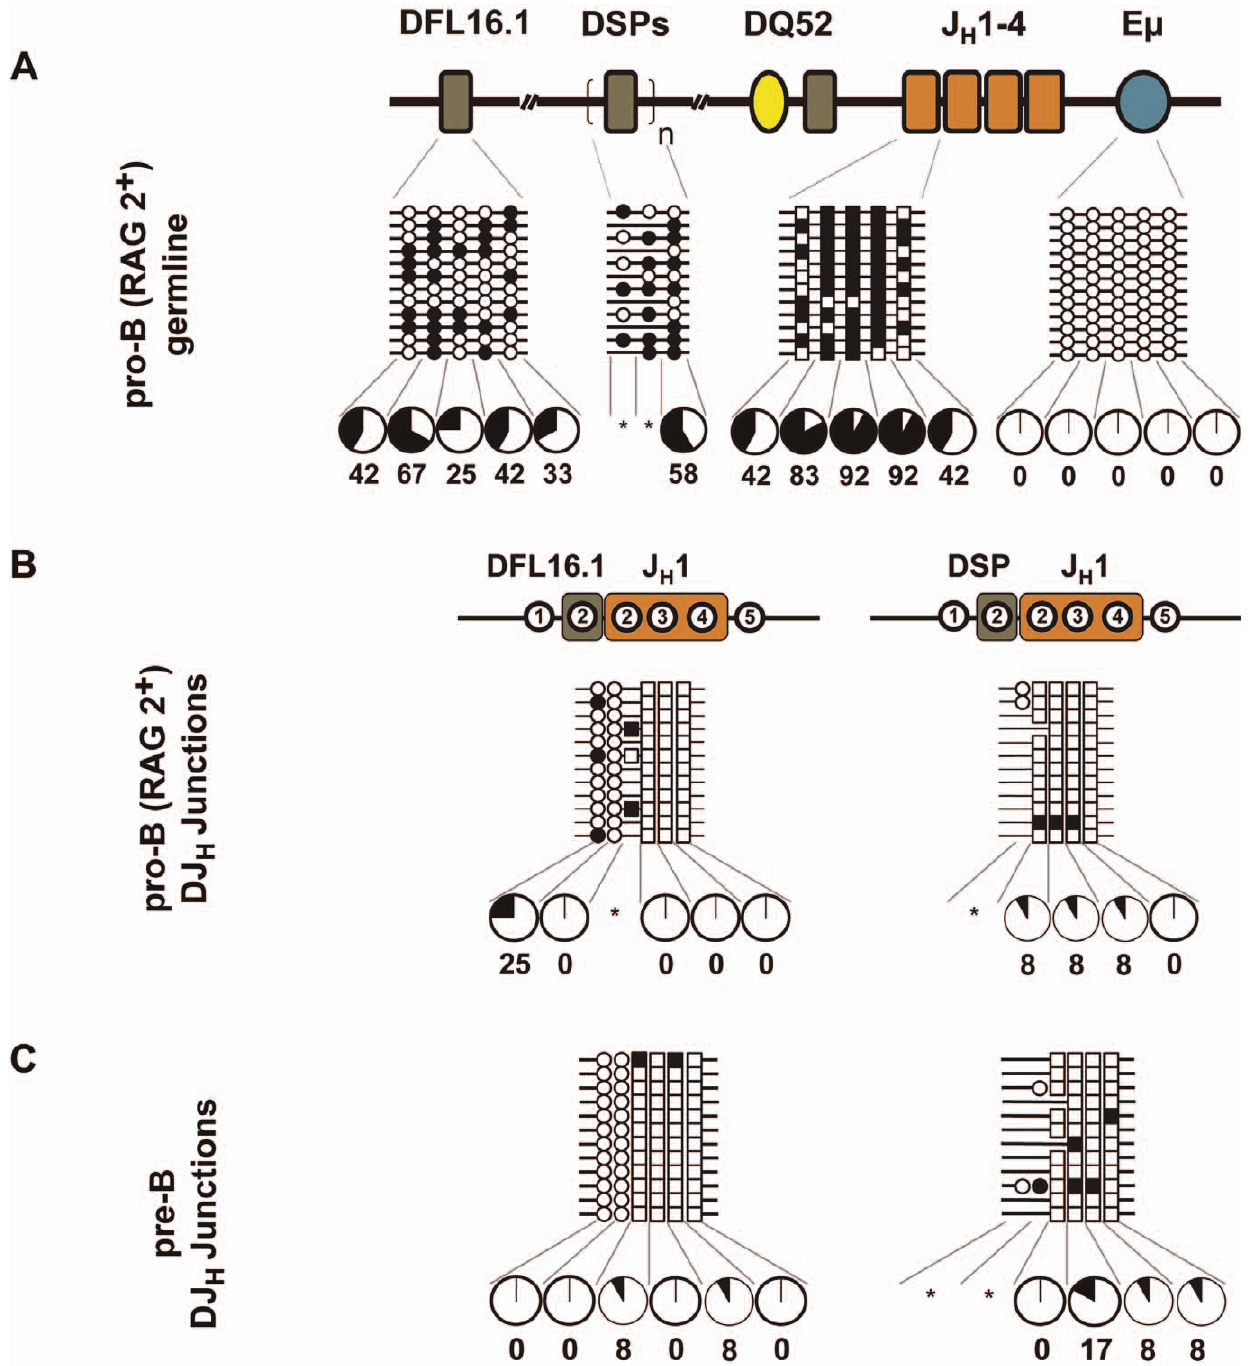
Figure 4. DNA methylation status after the first step of IgH locus recombination. Pro-B cells were purified from the bone marrow of wild- type C57BL/6 mice. Data shown are derived from two independent preparations of pro- and pre-B cells obtained from six to eight mice in each experiment. This cell population contains a mix of germline and partially rearranged IgH alleles. After bisulfite modification, the genomic DNA was used to amplify unrearranged (A) and DJ H rearranged junctions containing DFL16.1 and DSP gene segments (B). Cytosines derived from D H and J H gene segments are marked as circles and squares, respectively. Filled and open circles, or squares, indicate methylated and unmethylated cytosines, respectively. Numbers within regions marked as DFL16.1, DSP and J H 1 in (B) denote CpG dinucleotides corresponding to the configuration of these residues at the respective unrearranged gene segments. For example, of the five CpGs at unrearranged DFL16.1 only the first two are retained in DFL16.1/J H 1 junctions. The total numbers of CpG dinucleotides are reduced in junctional sequences because some residues are lost during VDJ recombination as described in the text. Additional heterogeneity is due to the imprecise nature of recombination. Pie charts summarize the percentage of methylated cytosines at each position, except where the number of alleles falls below 12 (indicated by asterisks). (C) Methylation state of recombined DJ H alleles in purified pre-B cells. This population contains a mix of VDJ H recombined and DJ H recombined IgH alleles (see Figure 5A). Note that the number of circles and squares representing D H - or J H -associated CpGs differed in the DJ H junctions compared to the corresponding unrearranged regions due to junctional variability. doi:10.1371/journal.pbio.1001475.g004 PLOS Biology |